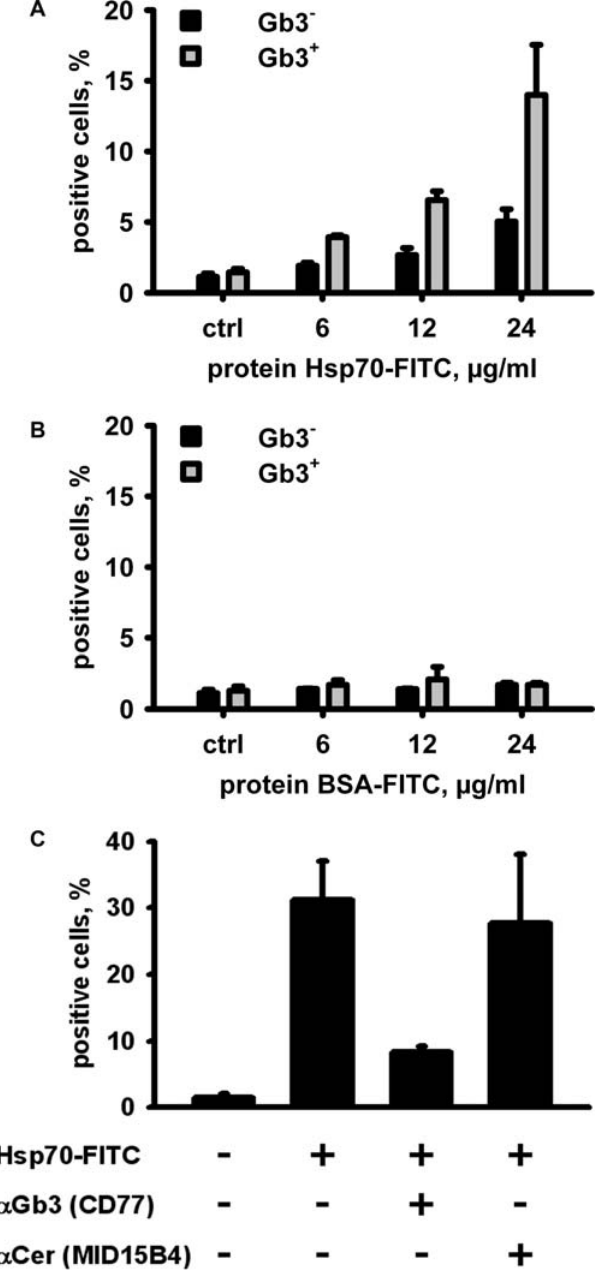
Figure 5. Binding of Hsp70-FITC, and BSA-FITC to viable Gb3 membrane-negative K562 and Gb3 membrane-positive Daudi cells. (A) Significant binding of Hsp70-FITC was observed to Daudi cells at a concentration of 12 m g/ml and 24 m g/ml. (B) BSA-FITC did neither bind to K562 nor to Daudi cells, at any of the tested concentrations. (C) Specific blocking of Hsp70-FITC binding by anti-Gb3 monoclonal antibody CD77. Daudi cells were kept either untreated or incubated with anti-Gb3 (CD77), or anti-ceramide (MID15B4) antibodies (5 m g/ml) for 30 min on ice prior to incubation with Hsp70-FITC (60 m g/ml, 30 min on ice) and analysis by flow cytometry.